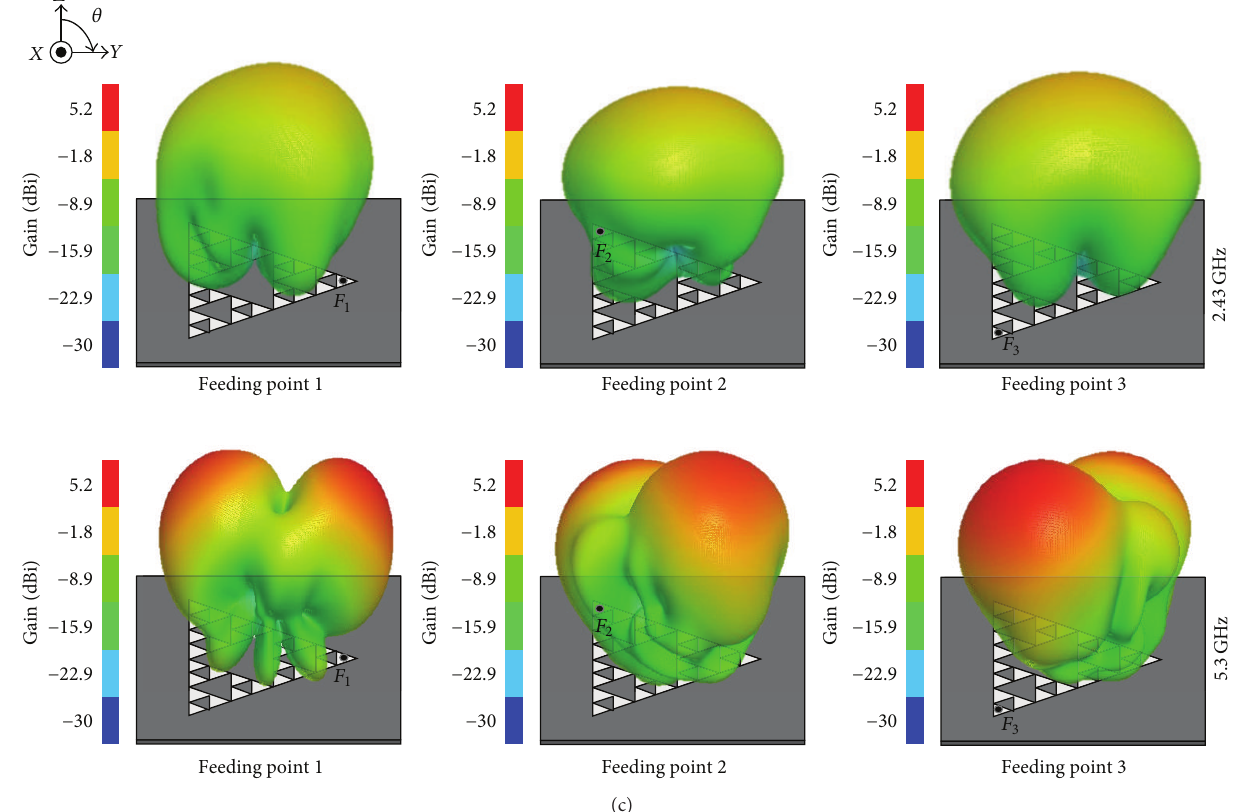
Figure 3: Simulated 3D radiation patterns of the proposed antennas: (a) 1st order, (b) 2nd order, and (c) 3rd order.